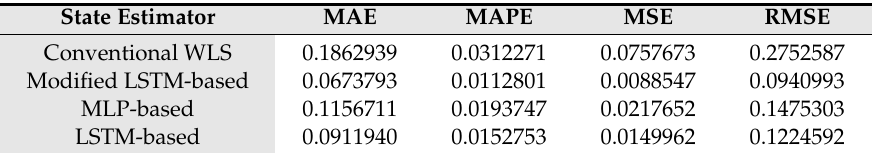
Table 2. Comparison of state estimator error values.